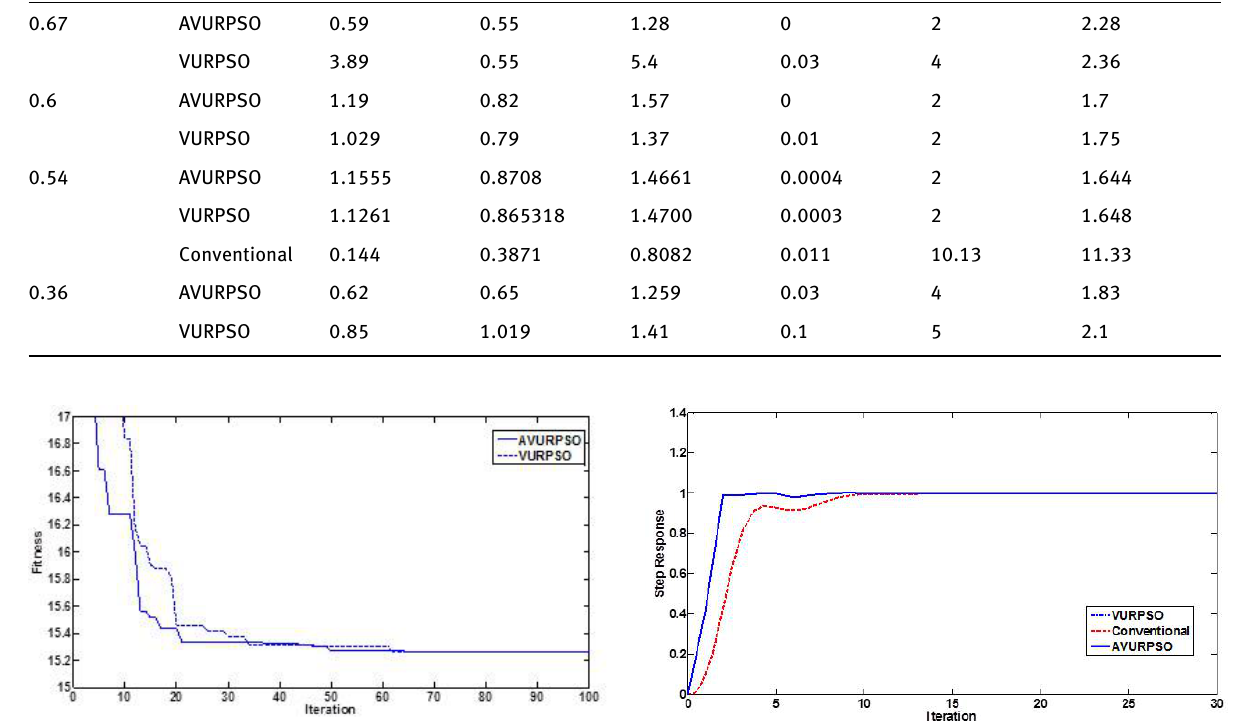
Figure 4: Comparing VURPSO, AVURPSO and Conventional design on performance of control in Example